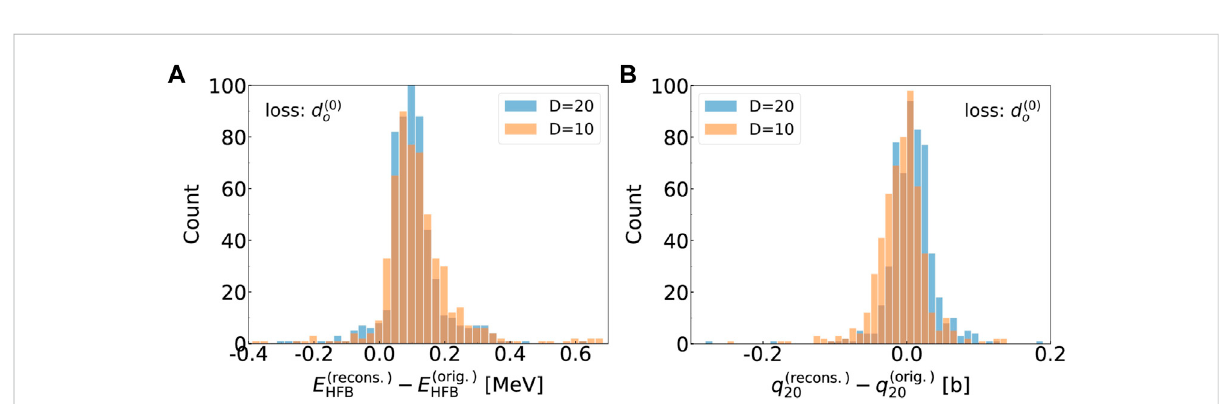
FIGURE 13 (A) :HistogramofthedifferenceintotalHFBenergybetweentheoriginalHFBTHOcalculation andtheresult obtainedbycomputingtheenergy in the canonical basis with the reconstructed wavefunctions (see text for details). Calculations were performed both for a D = 20 and D = 10 latent space. (B) : Similar histogram for the expectation value of the axial quadrupole